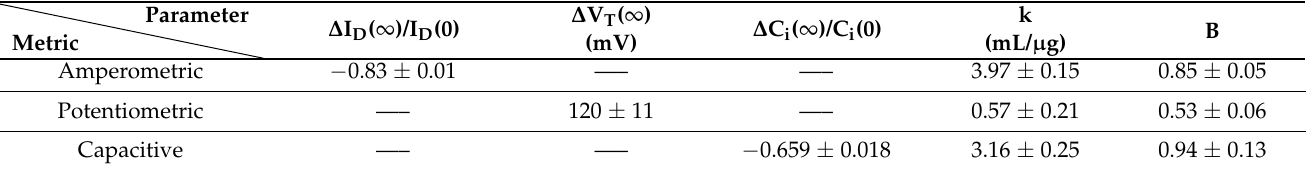
Table 2. Parameters from the fitting of the LF model, Equation (6), to the response metrics shown in Figures 4 and 6. Metric